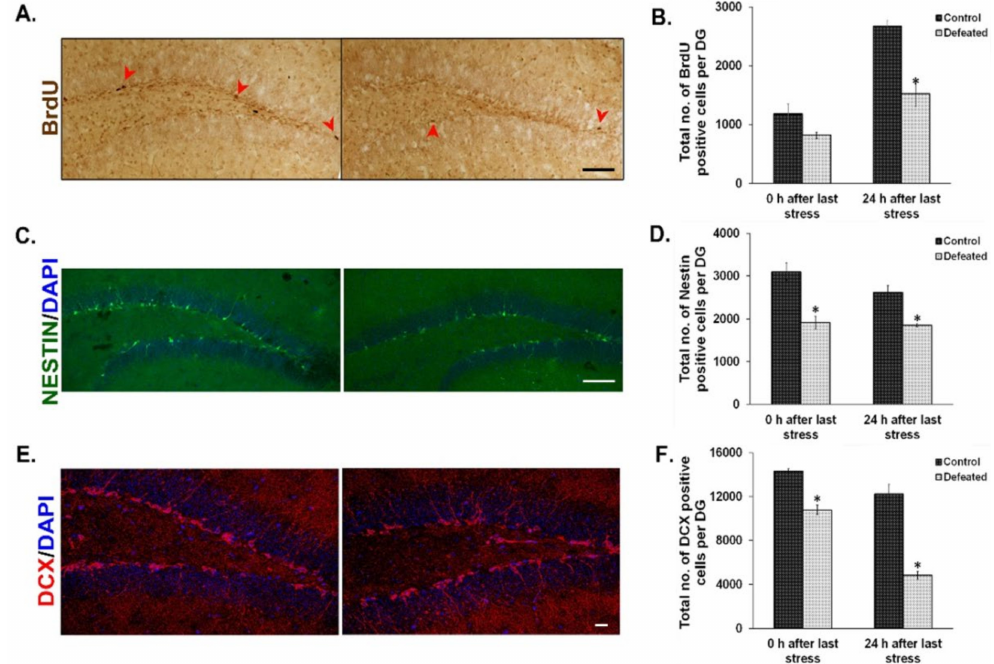
Figure 2. Social defeat stress leads to reduced neurogenesis in the hippocampal dentate gyrus (DG). ( A ) Representative images from BrdU staining in the DG of control (left) and defeated (right) mouse after 24 h of last defeat. Scale bar represents 100 µ m. ( B ) Quantitative analysis revealed a significant decrease in the number of BrdU positive cells in the DG of defeated mice as compared to the control mice at 24 h after the last stress episode. ( n = 4–5 mice / group). ( C ) Representative images of Nestin-GFP positive cells in the DG of control (left) and defeated (right) mouse 24 h after the last stress. Scale bar represents 100 µ m ( D ) Quantitative analysis revealed a significant decrease in the Nestin-GFP positive cells in the DG of the defeated mice sacrificed immediately or after 24 h of the last stress ( n = 5–6 / group). ( E ) Representative images of Doublecortin (DCX) positive cells in the DG of control (left) and defeated (right) mouse after 24 h of the last defeat episode. Scale bar represents 200 µ m ( F ) The number of DCX positive cells is significantly reduced in the DG of the defeated mice sacrificed immediately and after 24 h of the last stress episode than the control mice ( n = 4 / group). * p <